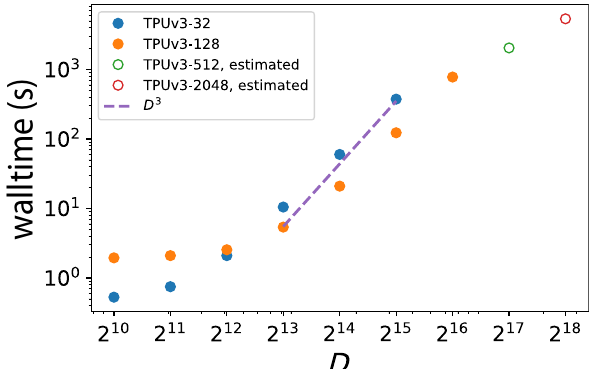
FIG. 4. Measured and estimated runtimes per DMRG opti- mization step (including the Lanczos update, tensor orthogonal- ization, and update of the effective environment Hamiltonian) on different TPU cluster sizes. The solid line is proportional to the expected D 3 scaling of the DMRG algorithm.